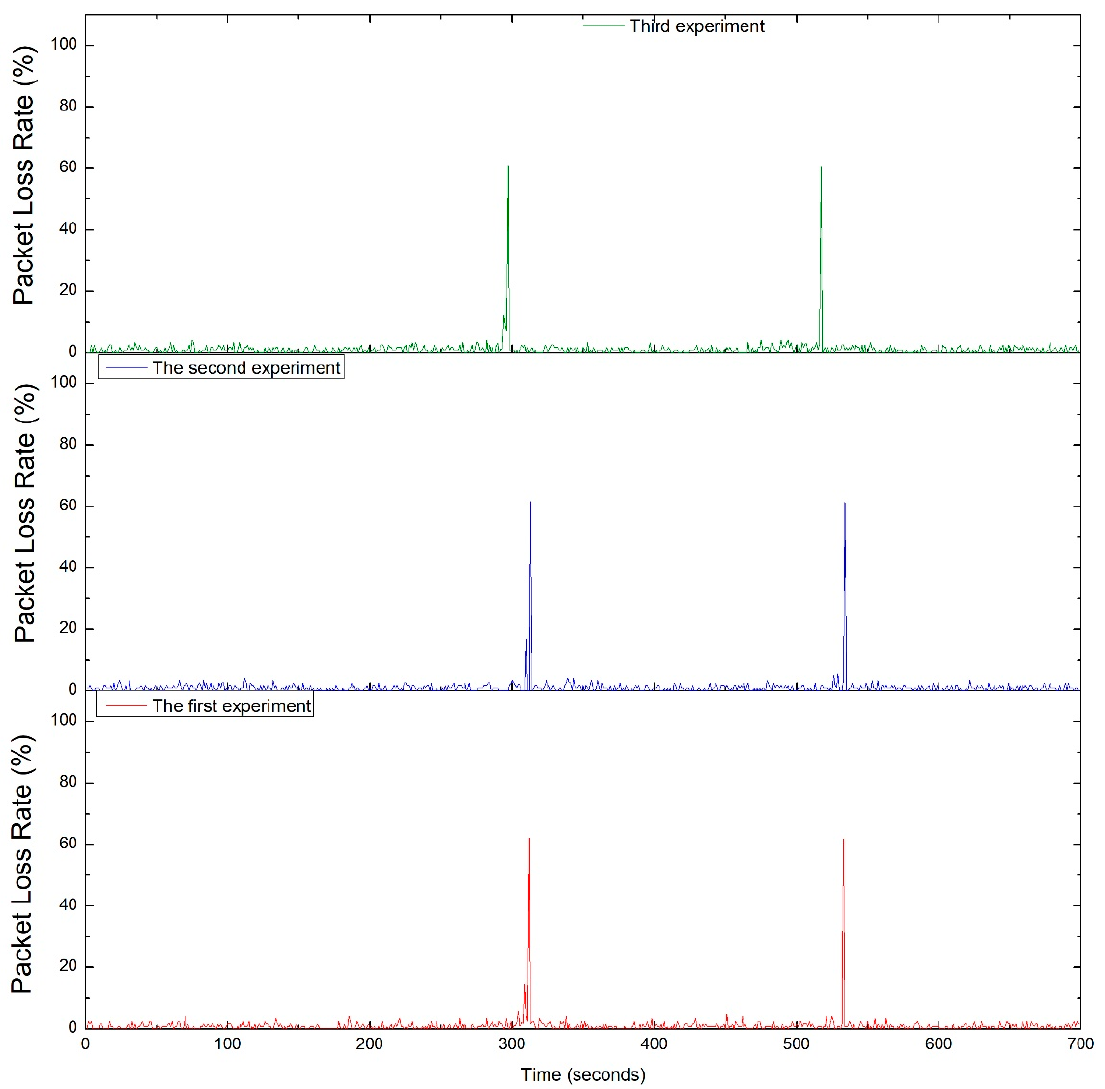
Figure 21. The packet loss rates of three experimental results of the proposed deep-learning-based handover mechanism.